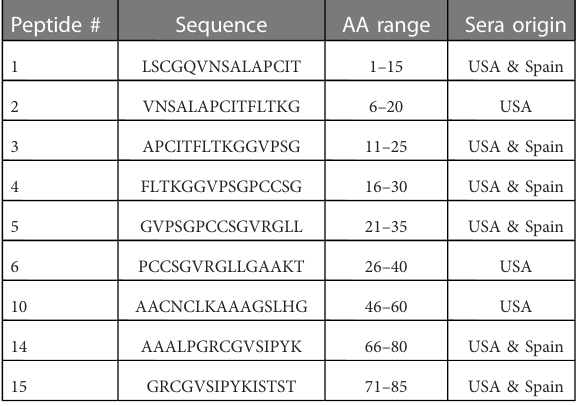
TABLE 4 Major IgE binding peptides of Ara h 9 by